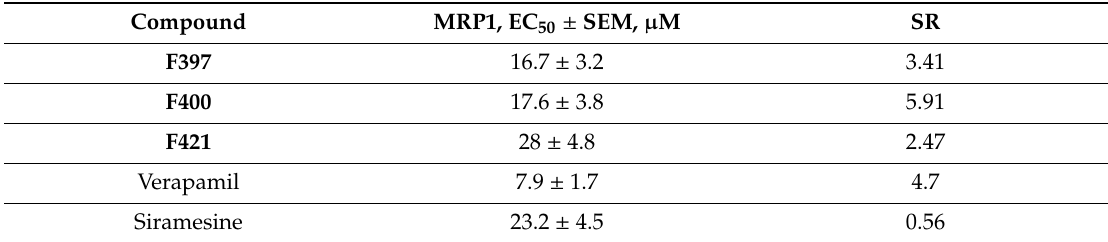
Table 1. MRP1 activity and collateral sensitivity activity (selectivity ratio, SR) of the three compounds F397 , F400 , and F421 , and the two reference compounds verapamil and siramesine.